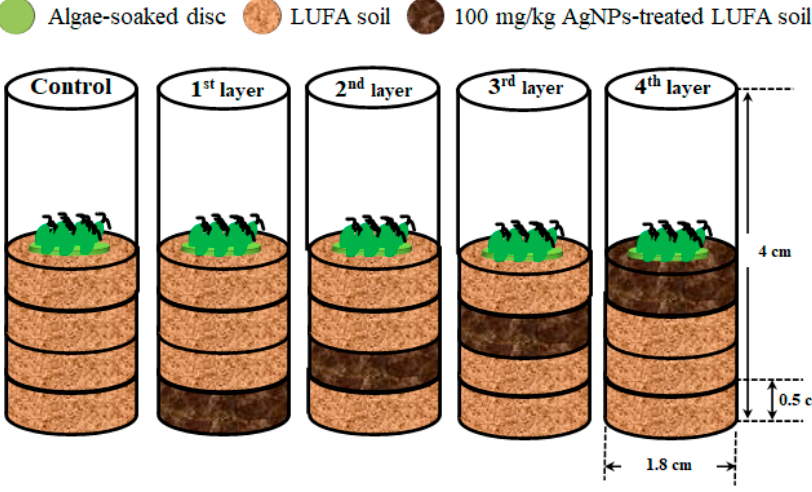
Figure 2. A diagrammatic sketch showing how the periodic evaluation of silver nanoparticles could be used as a biomonitoring technique to evaluate subsoil quality. be used as a biomonitoring technique to evaluate subsoil